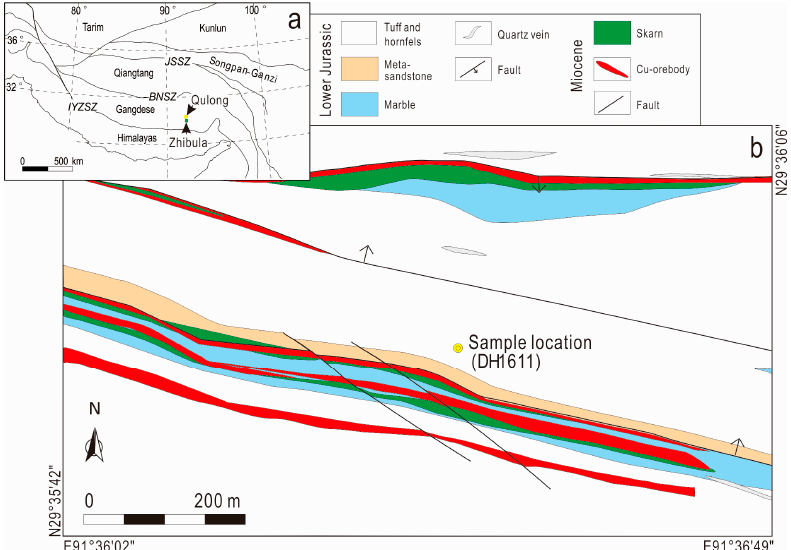
Figure 1. Simplified geological map of the Zhibula Cu skarn deposit. Abbreviations: JSSZ, Jinsha Suture Zone; BNSZ, Bangong–Nujiang Suture Zone IYZSZ; Indus–Yarlung Zangbo Suture